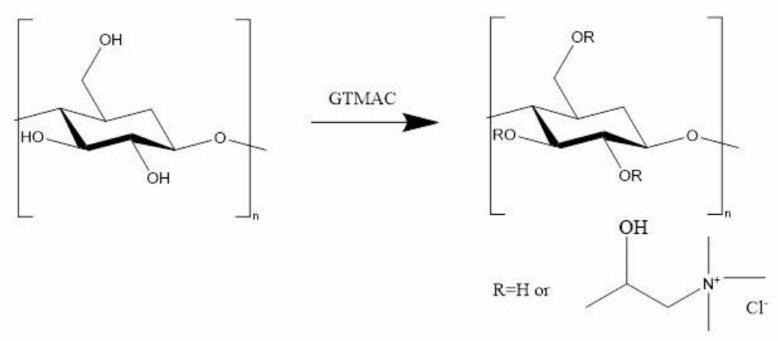
Figure 3. Scheme of beta-glucan cationization reaction used in this